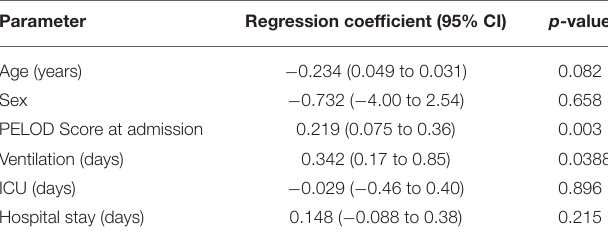
TABLE 7 | Association of peak fluid overload and clinical parameters.